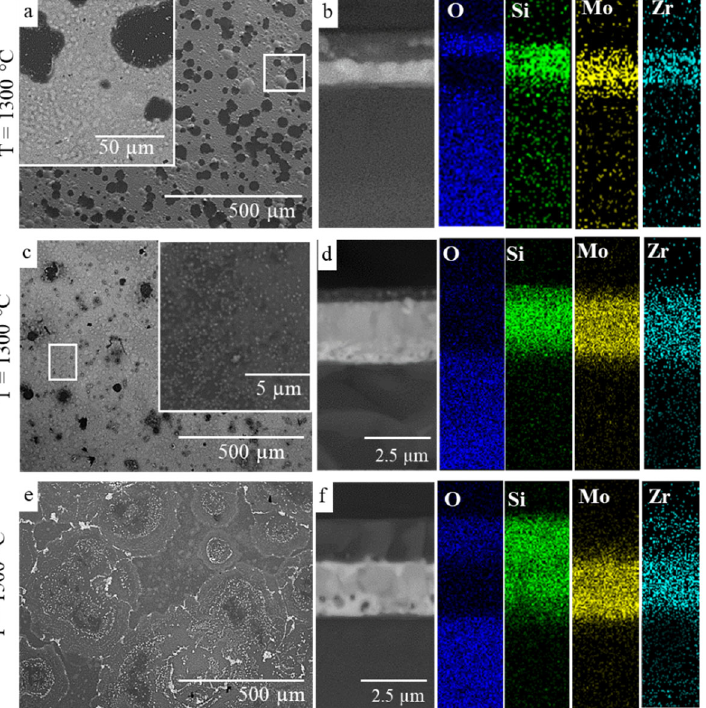
Figure 6. SEM images of the surface ( a , c , e) and cross-section fracture ( b , d , f ) of the coatings deposited at frequencies of 50 ( a , b , e , f ) and 200 Hz ( c , d ) after annealing in air at 1300 and 1500 °C.